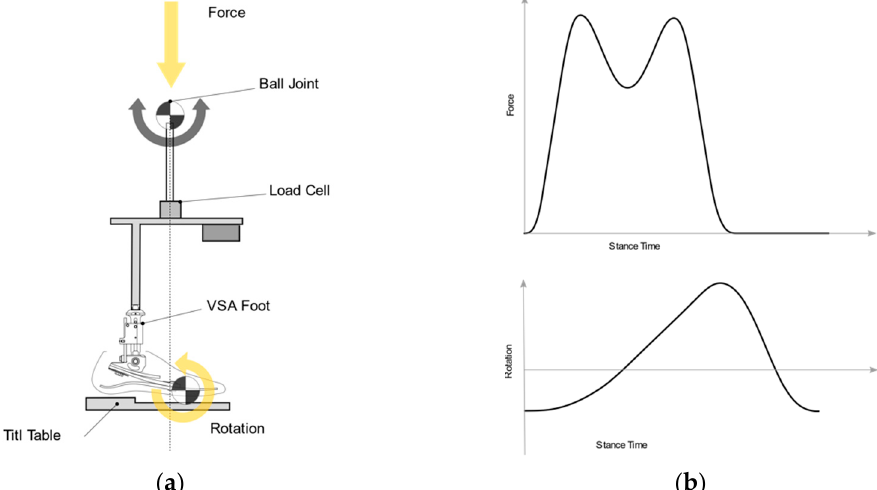
Figure 3. Schematic illustration of foot roll-over testing according to ISO/TS 16955: ( a ) machine setup with a VSA prosthetic foot sample (yellow arrows showing force and rotation); ( b ) vertical force on ball joint and rotation of the tilt-table, as functions of stance phase time.